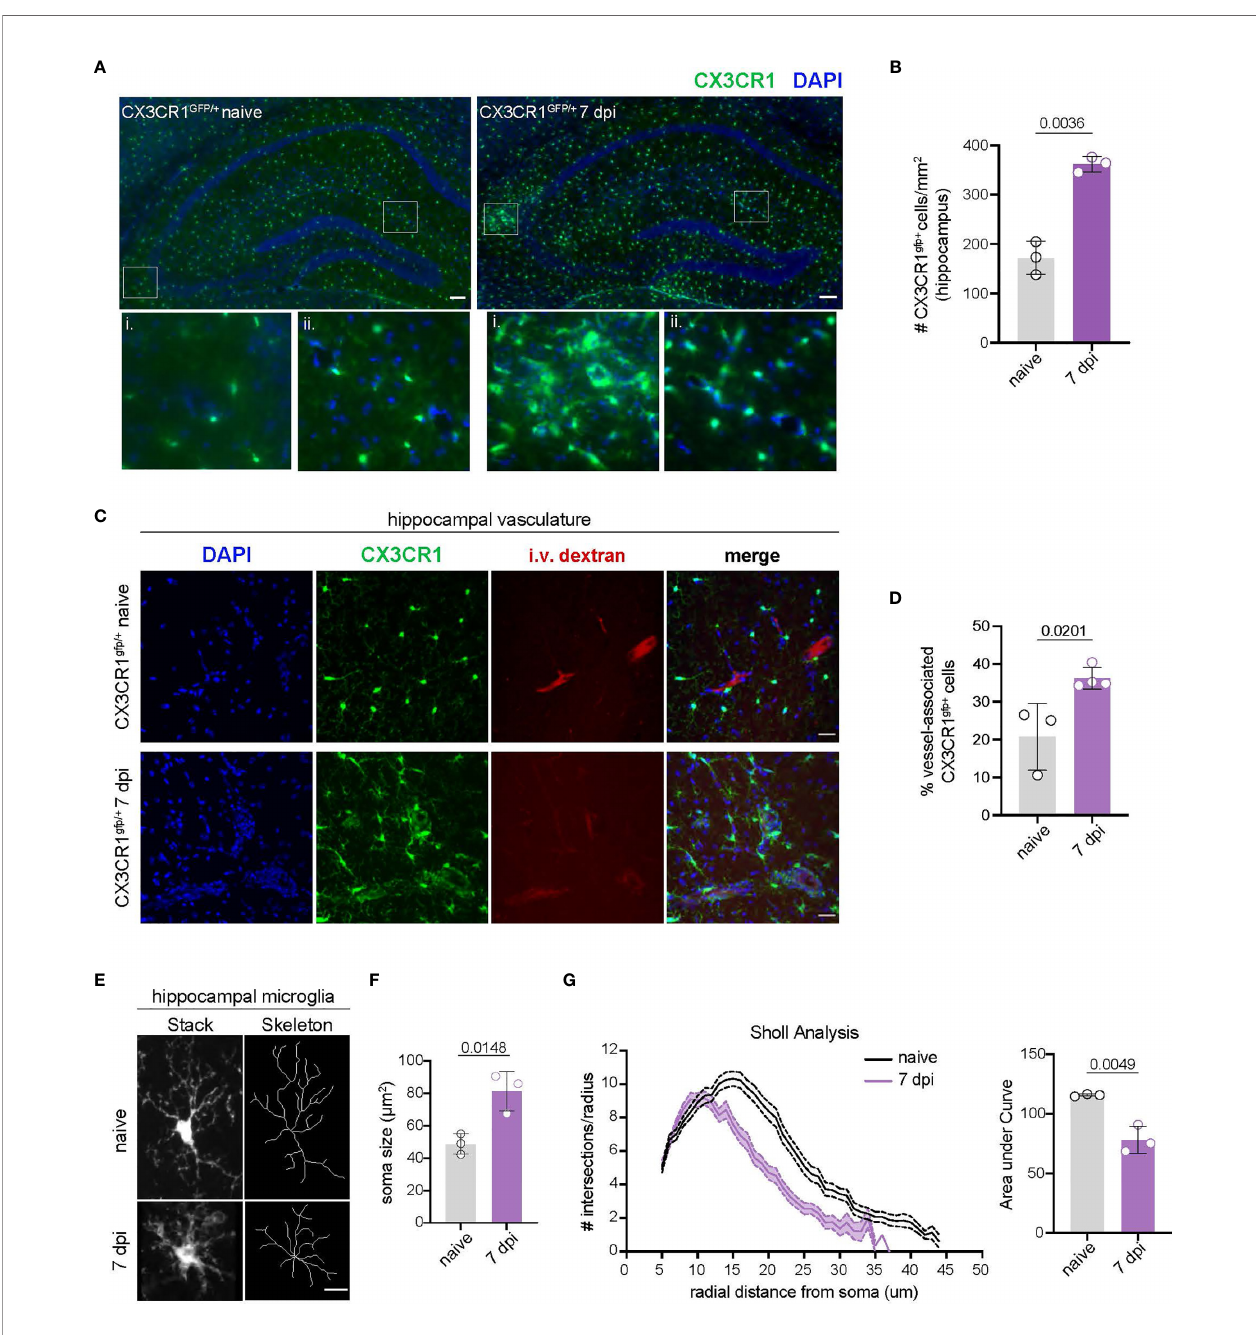
FIGURE 2 | TMEV infection induces CNS-myeloid cell activation and vessel association in the hippocampus. (A) CX3CR1 + CNS-myeloid cells (green) in representative hippocampal images from uninfected and TMEV infected (7 dpi) CX3CR1 gfp/+ mice. Zoomed insets demonstrate areas in which CX3CR1 + cells cluster around vasculature. n = 3 mice (3 sections/mouse). Scale bars: 100 m m. (B) Density of hippocampal CX3CR1 + cells in naïve and TMEV infected mice. (C) Representative images of DAPI (nuclei, blue), CX3CR1 (CNS-myeloid, green), and intravascularly injected dextran (vasculature, red) in the hippocampus of naïve and TMEV-infected mice. n = 3 mice (6 sections/mouse). Scale bars: 25 m m. (D) Quanti fi cation of the proportion of CX3CR1 + cells in contact with hippocampal vasculature in naïve and infected conditions. (E) Representative images of hippocampal microglial morphology (confocal and transformed skeletal) in uninfected and TMEV infected mice (7 dpi). n = 3 mice (3 sections/mouse). Scale bars: 10 m m. (F) Quanti fi cation of hippocampal microglia soma size at 7 dpi TMEV compared to naïve. (G) Sholl analysis of microglia at 7 days post TMEV infection or during steady state. (25 microglia/section, 2 sections/mouse). Area under the curve of the Sholl analysis is used